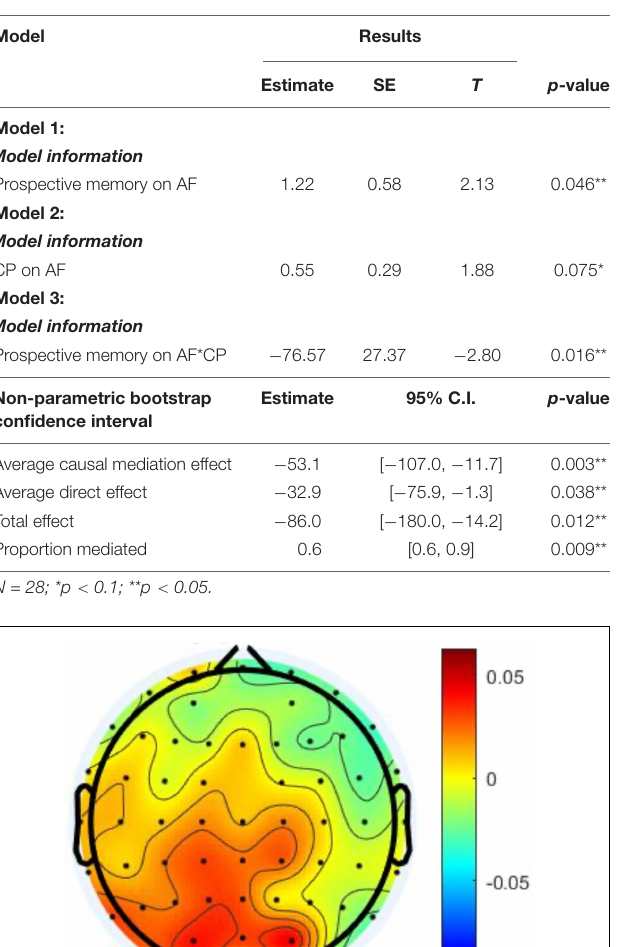
TABLE 3 | Regression of prospective memory on AF and prospective memory.